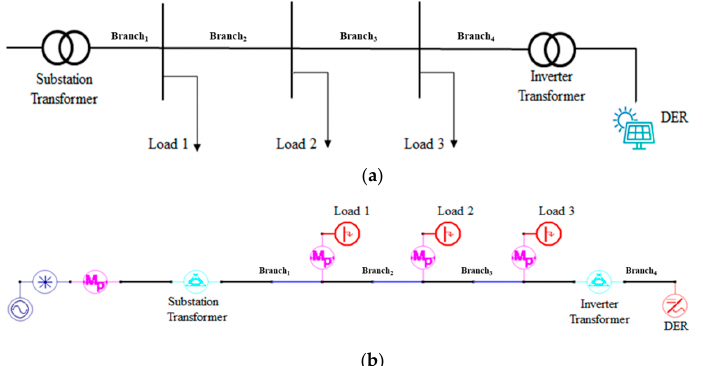
Figure 4. Structure of the feeder for simulation ( a ); Feeder circuit in the DEW ( b ).